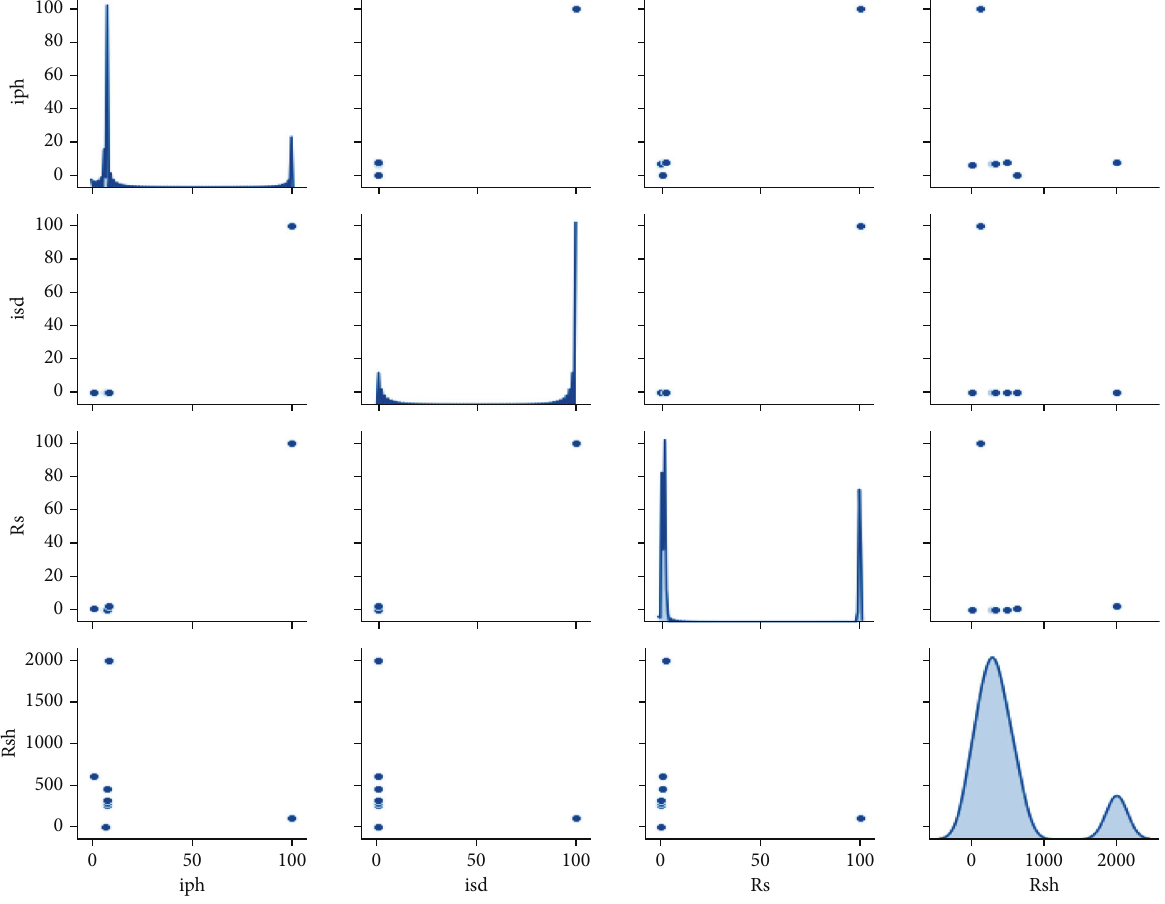
Figure 11: Two by two visualization of the training data.